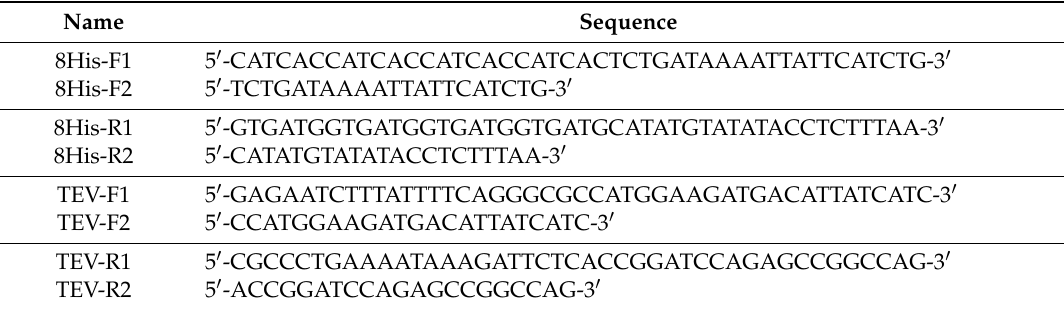
Table 5. Oligonucleotides used for mutagenesis experiments in this